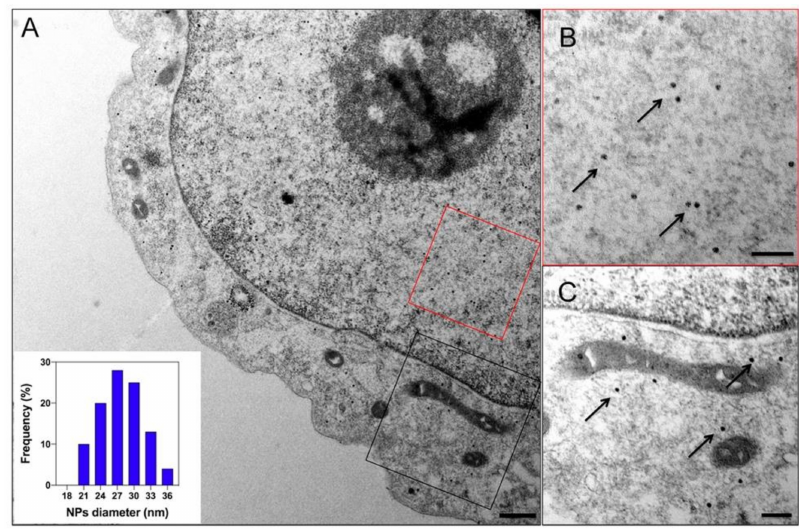
Figure 6. Iron oxide nanoparticle formation within EncQt nanocompartments in human cells. ( A ) Electron microscopy thin section image of HepG2 cells transiently expressing EncQt with its natural ferroxidase IMEF and the iron transporter Zip14. Bar, 500 nm. The inset shows the size distribution of iron oxide cores inside the encapsulin nanocontainers. ( B , C ) The close-up views show representative areas in the nucleus (( B ), red rectangle) and cytosol (( C ), black rectangle)). Arrows indicate individual iron-containing nanoparticles. Bar, 200 nm. Reprinted from